Question: From the figure, is the trend upward or downward?
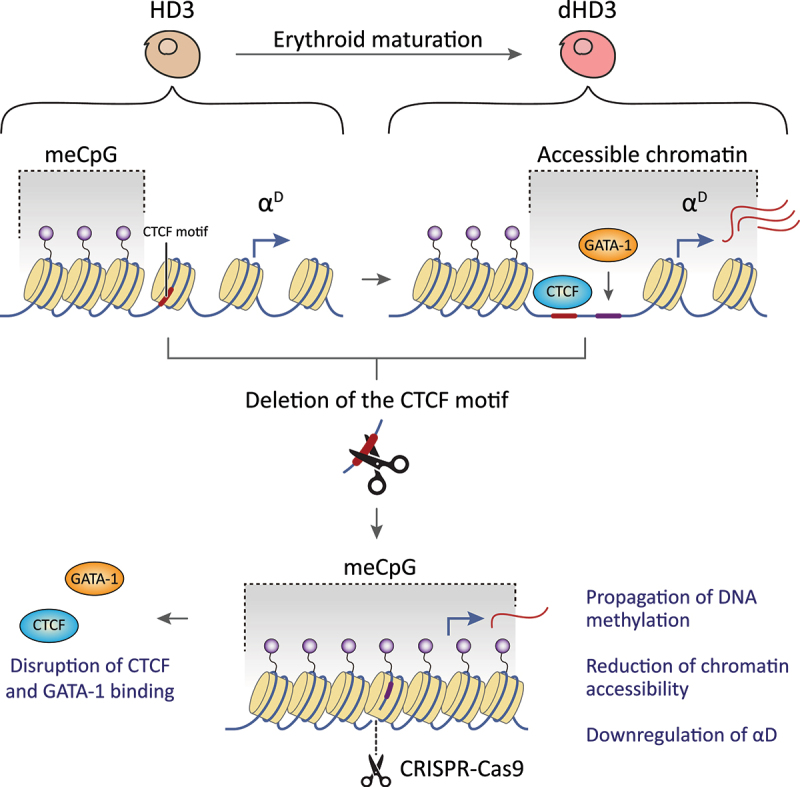
Answer: increasing